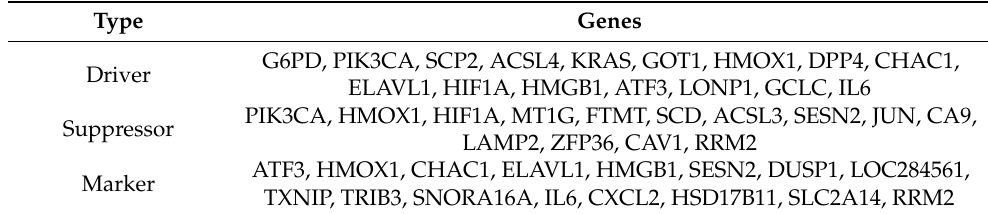
Table 1. The 35 overlapping genes and their role in ferroptosis.